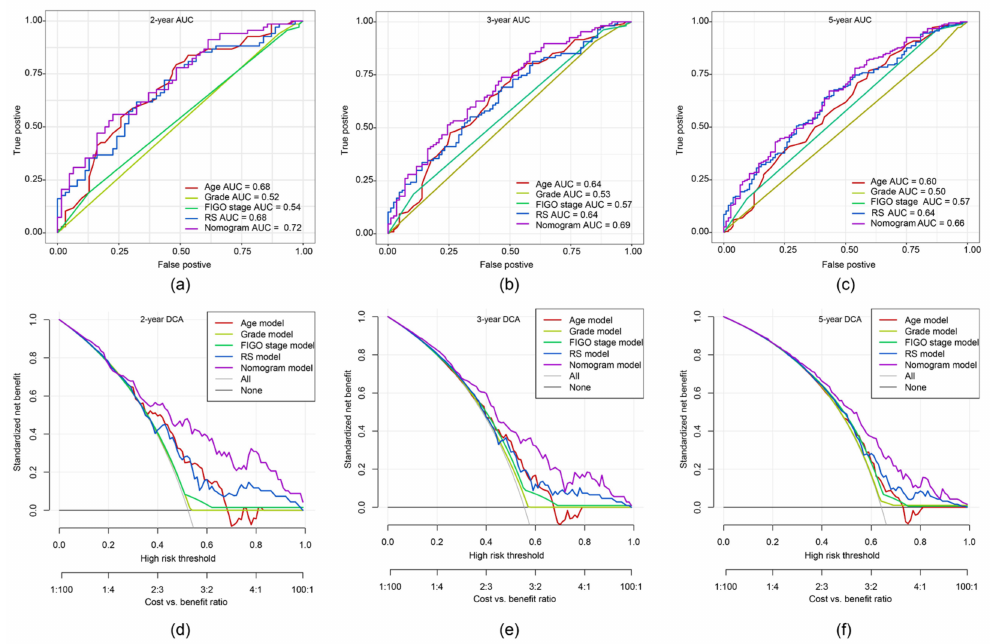
Figure 8. The time-dependent ROC curve and decision curve analysis (DCA) on the nomogram compared to single variable models. Through the ROC curves the accuracy of the models was tested for: ( a ) 2-year survival; ( b ) 3-year survival; ( c ) 5-year survival. The DCA curves can evaluate the clinical benefit of the nomograms and the scope of application. Black indicates that all samples are negative and none are treated, therefore the net benefit is 0. Grey indicates that all samples are positive and all are treated. The x-axis represents threshold probabilities of patients having: ( d ) 2-year survival; ( e ) 3-year survival; ( f ) 5-year